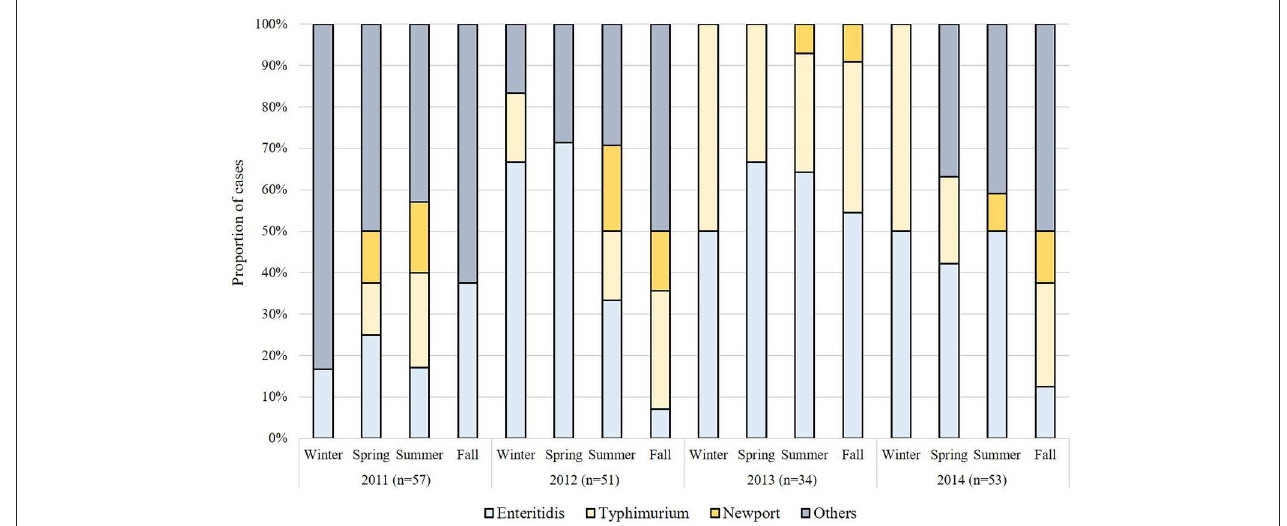
FIGURE 1 | Seasonal variation in the distribution of non-typhoidal Salmonella (NTS) serovars in Michigan by year.